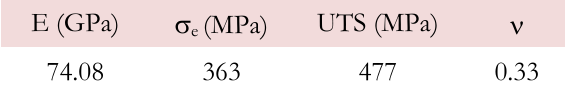
Table 1: Mechanical properties of 2024 T351 Al-alloy.